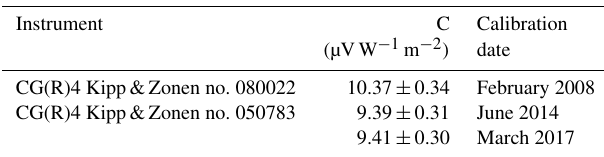
Table 1. CG(R)4 pyrgeometers installed at